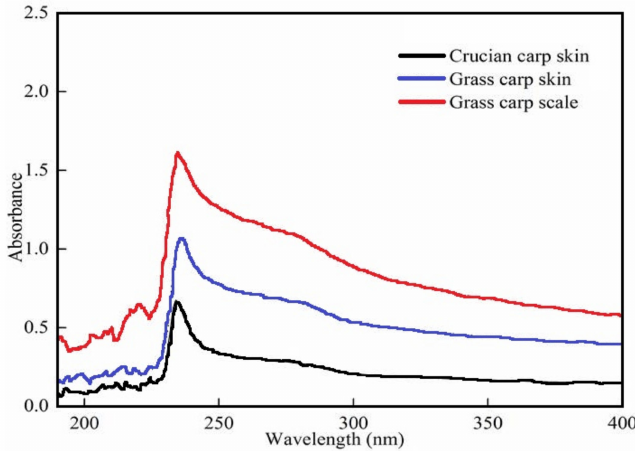
Figure 1. UV spectrum of type I collagen from grass carp skin, crucian carp skin and grass carp scales.